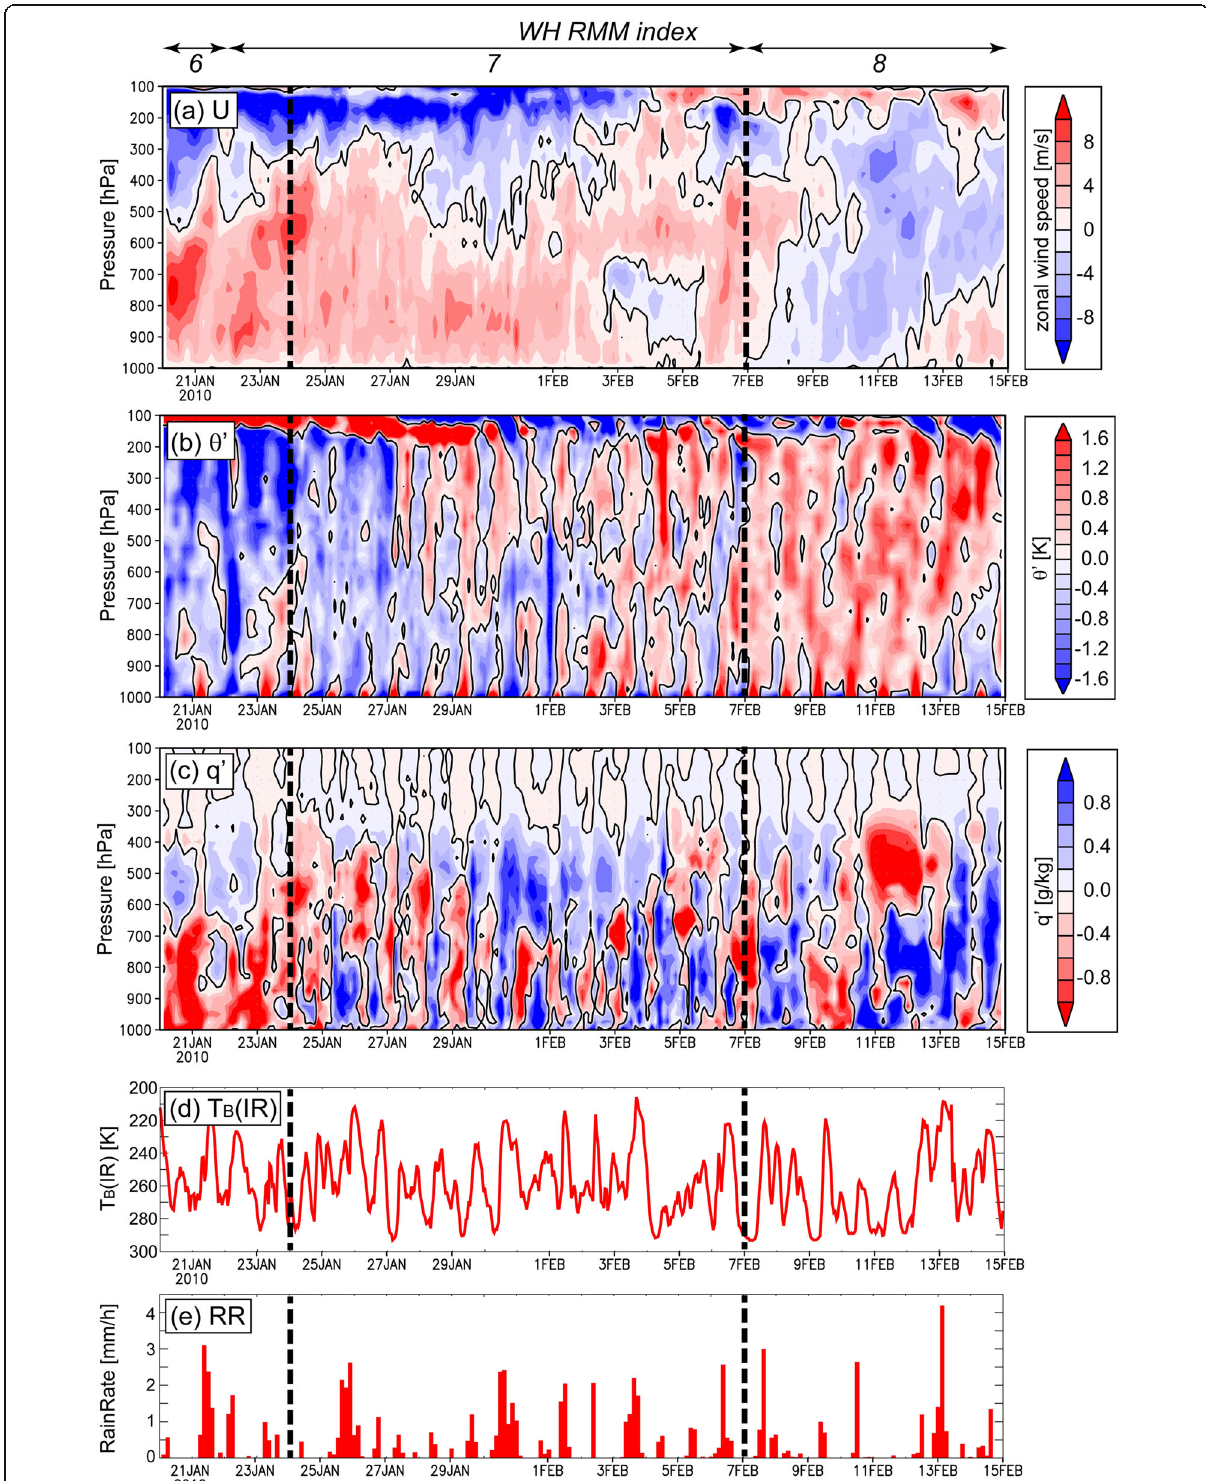
Fig. 3 Time – height cross sections of the sounding-derived parameters averaged over the array: a the zonal wind, b potential temperature anomaly, c moisture anomaly, d T B (IR), and e TRMM 3B42 rainrate are shown. All values are averaged over the array. Anomalies in b and c are from the average through the ASP at each pressure level. The vertical dashed black lines indicate the start and the end of the EASP. The MJO index by Wheeler and Hendon (2004) is shown on the